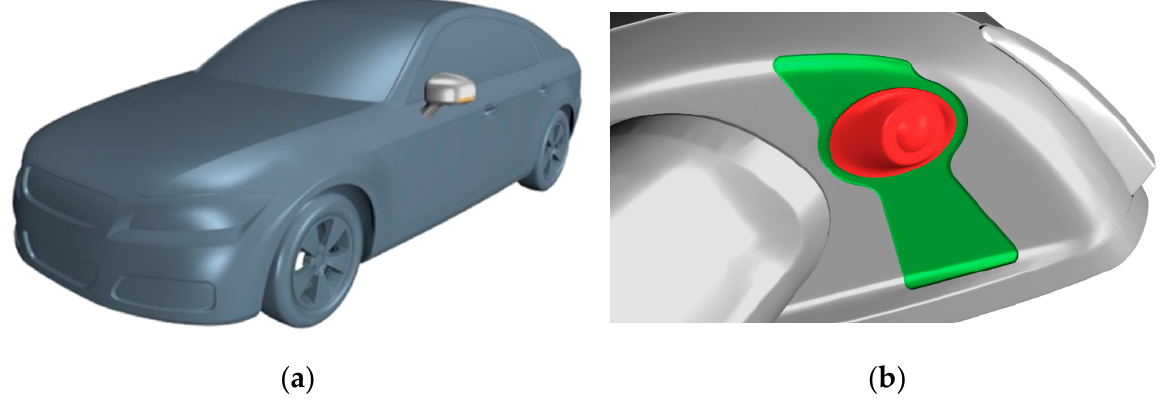
Figure 8. DrivAer car model ( a ) and detail of Volvo side mirror ( b ).